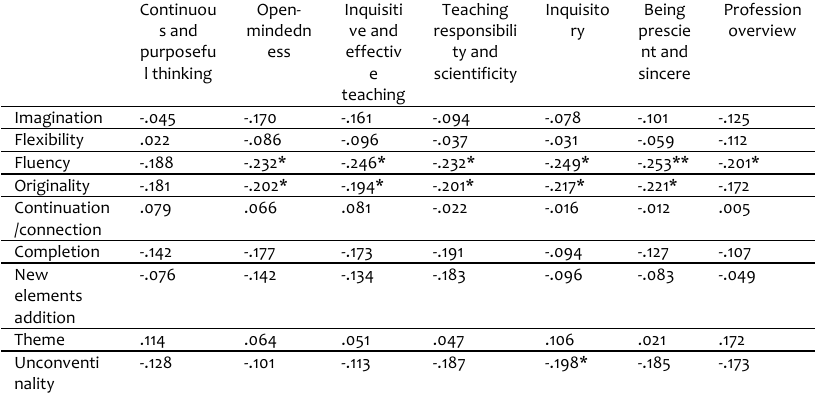
Table 1. Correlation values between pre-school teachers' reflective thinking tendencies and preschool children's creativity levels